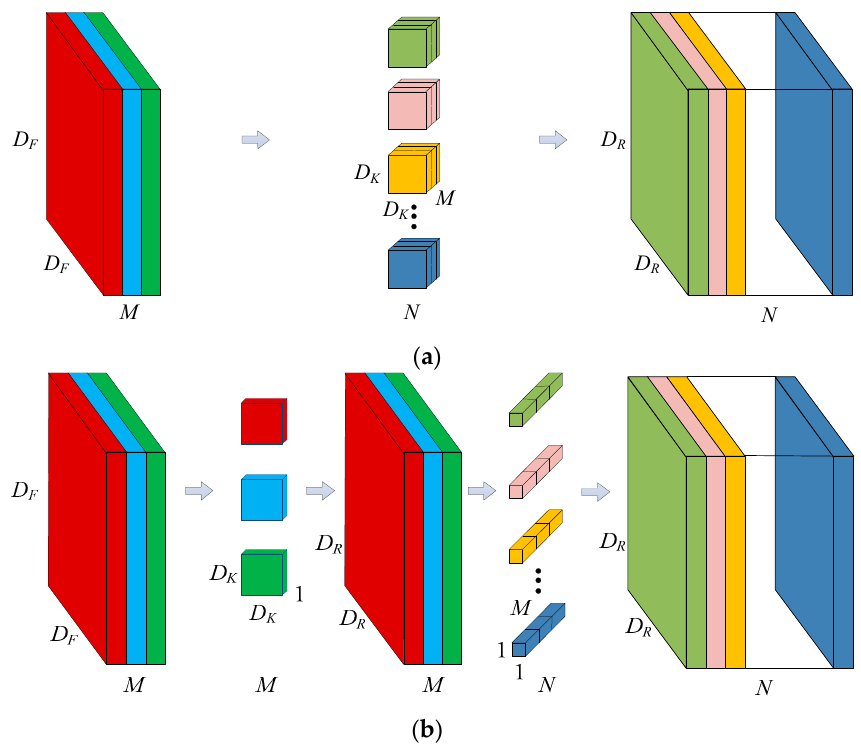
Figure 4. The difference between ( a ) standard convolution and ( b ) depthwise separable convolution. D K is the width and height of the convolution kernels, D R is the width and height of the output feature maps, M is the channel number of the input feature maps and N is the channel number of the output feature maps.